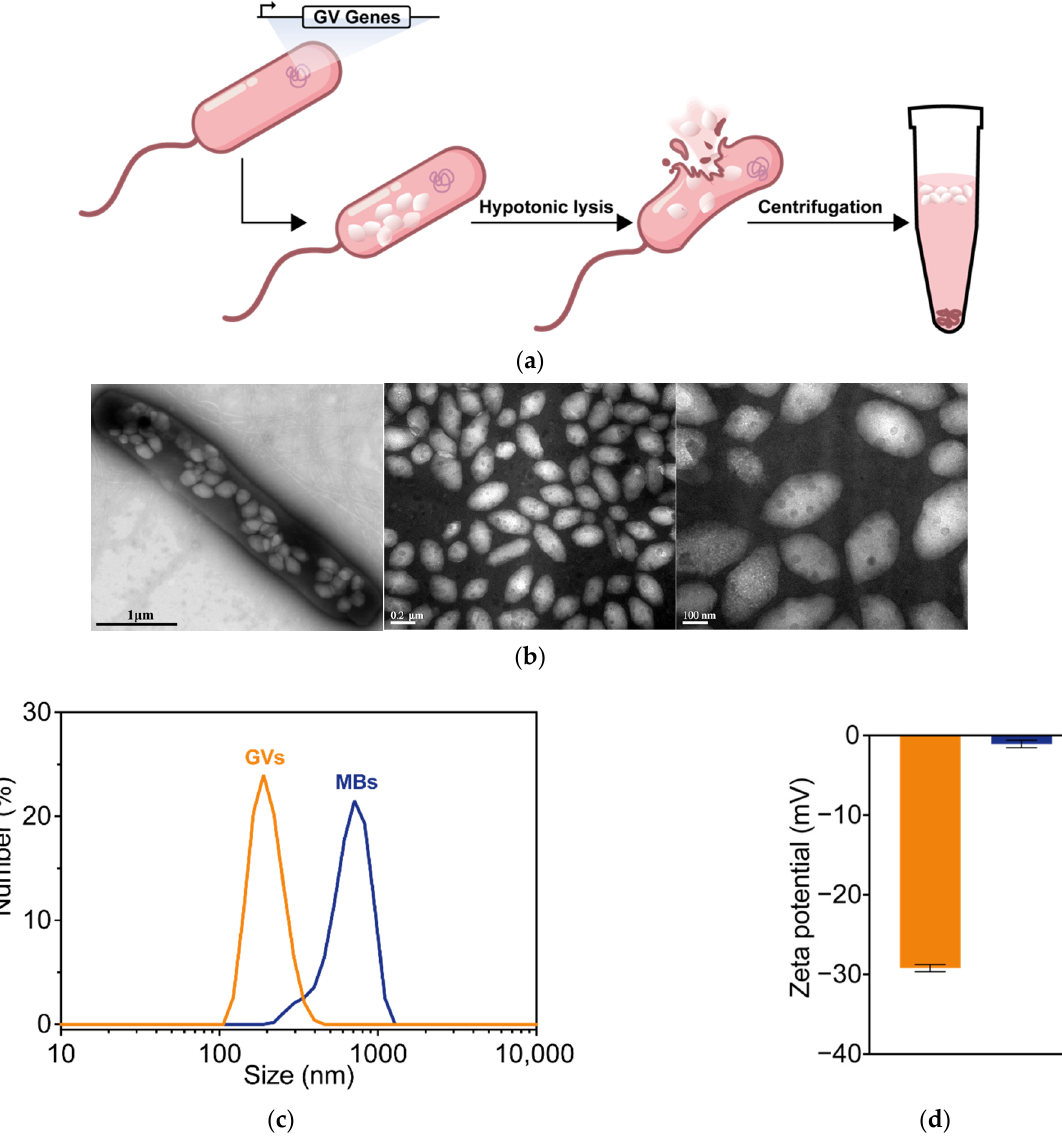
Figure 1. Preparation and characterization of GVs: ( a ) diagram of preparation of biosynthetic GVs; ( b ) TEM images of Halo (left) and GVs (middle and right); ( c ) particle size distribution of GVs and lipid MBs; ( d ) zeta potential of GVs and lipid MBs. Error bars represent ± SD.